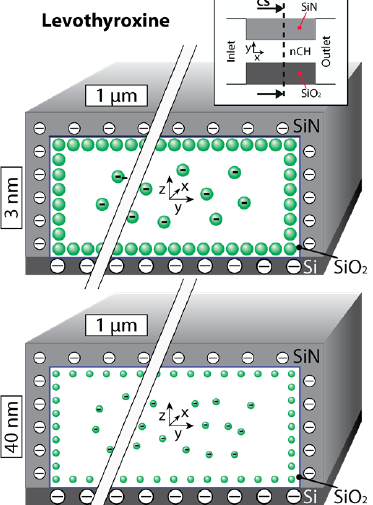
Figure 2. Nanochannel cross (CS) sections depicting levothyroxine distributions within 3 and 40 nm nanochannel membranes are shown. Neutrally charged molecules move near the wall surface while negatively charged molecules tend to migrate towards the center of the nanochannel. Please note that the aspect ratio was lessened for better visual representation of the molecular distribution.